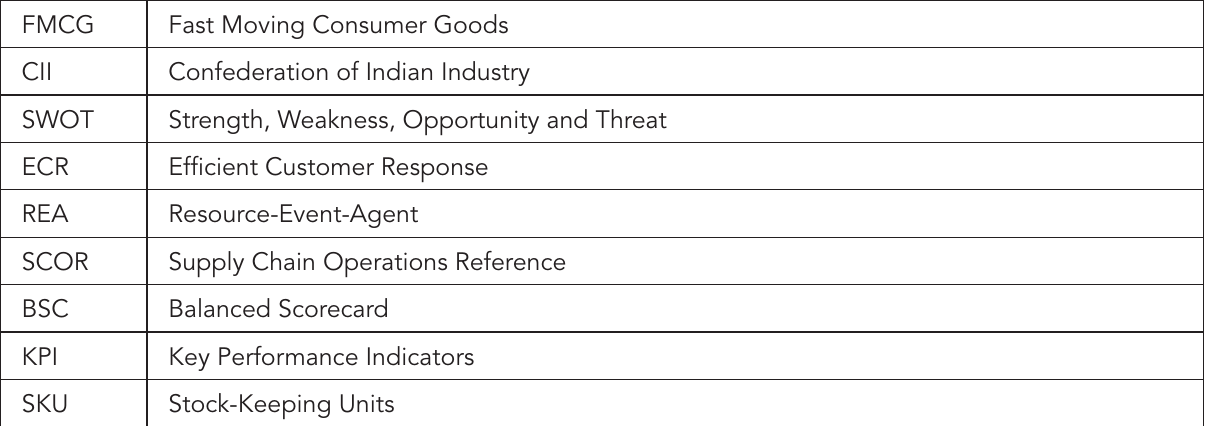
Key Performance